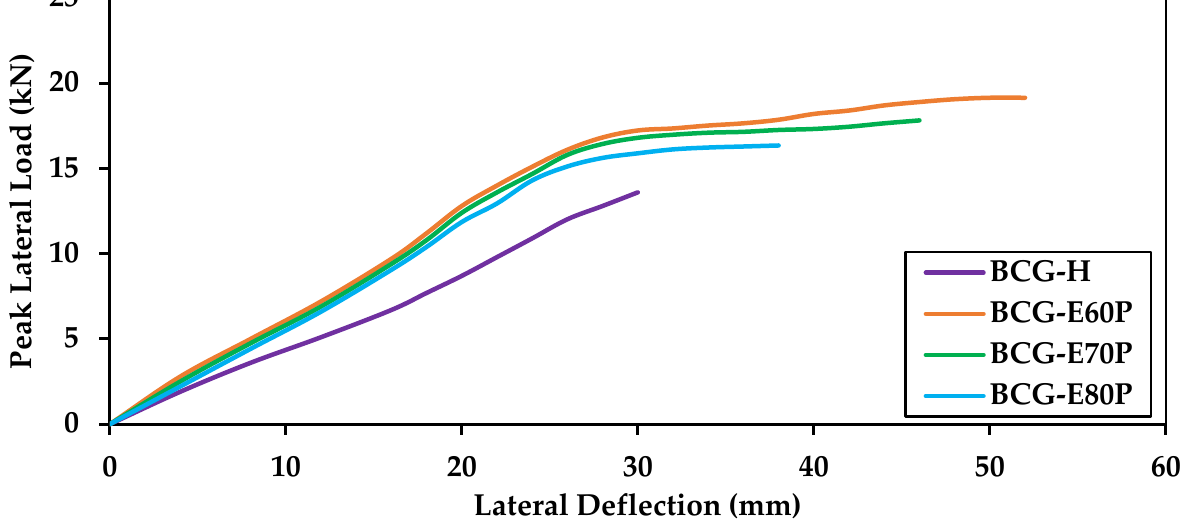
Figure 13. Cyclic envelope curve of GFRP with and without HVFA-ECC beam-columns.